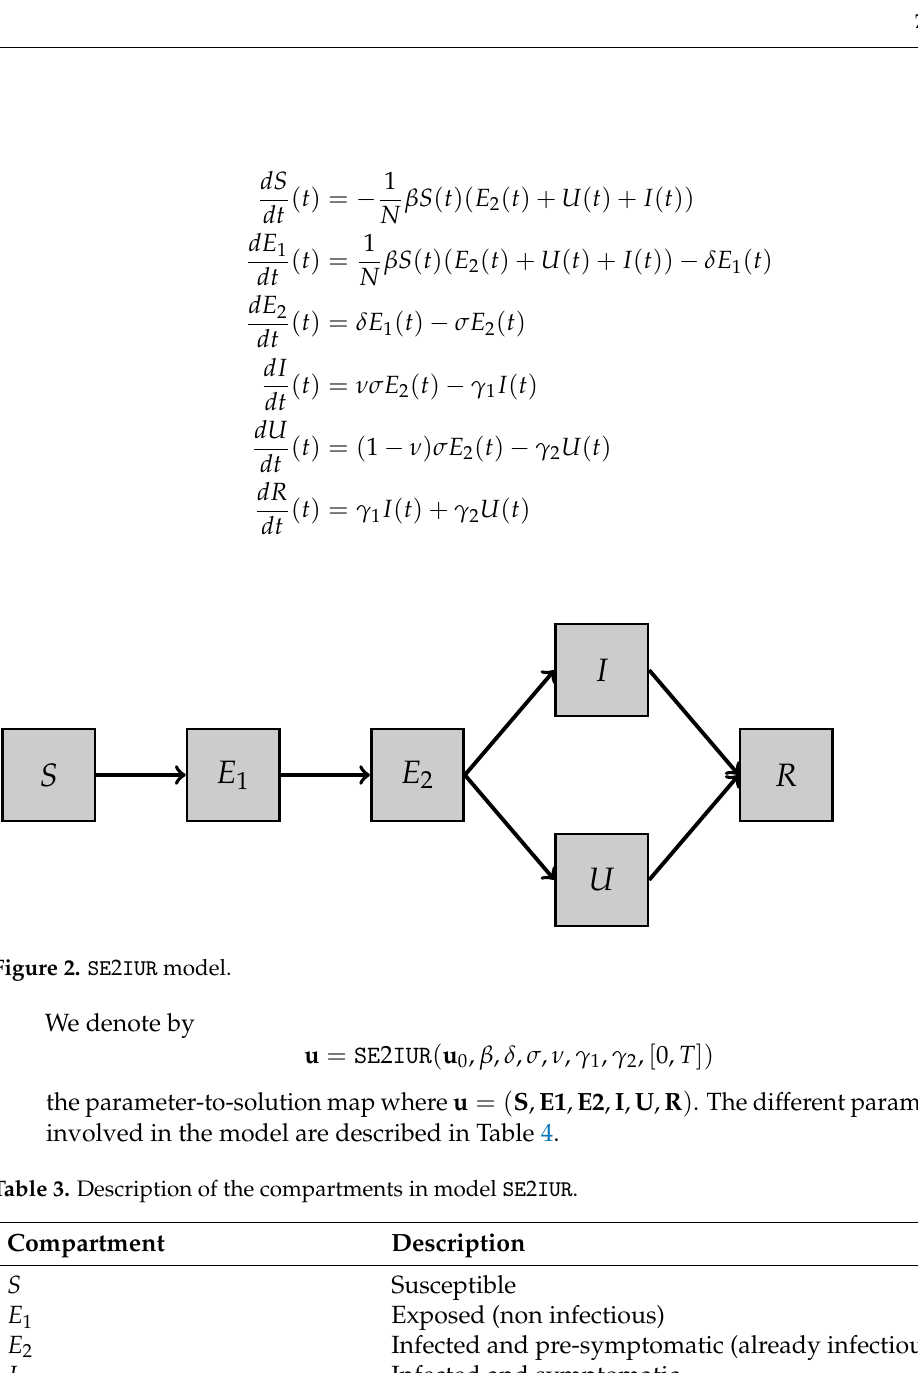
Table 3. Description of the compartments in Model SE 2 IUR